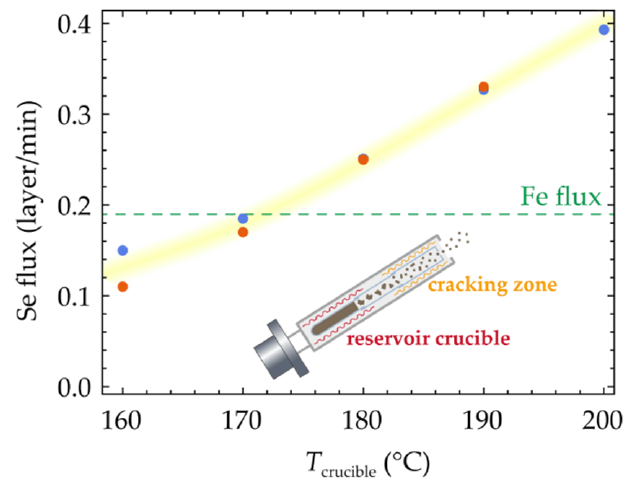
Figure 1. Selenium flux measured by a QCM as a function of the reservoir temperature while keeping the cracking zone at 1000 ◦ C. Red and blue data points are from two sets of measurements a month apart. The yellow band is a guide for the eye. The Fe flux is fixed in this study, indicated by the green dashed line. The flux unit is converted to number of layers per minute, considering the density of the element in the tetragonal FeSe. The inset is a schematic of the Se cracker.